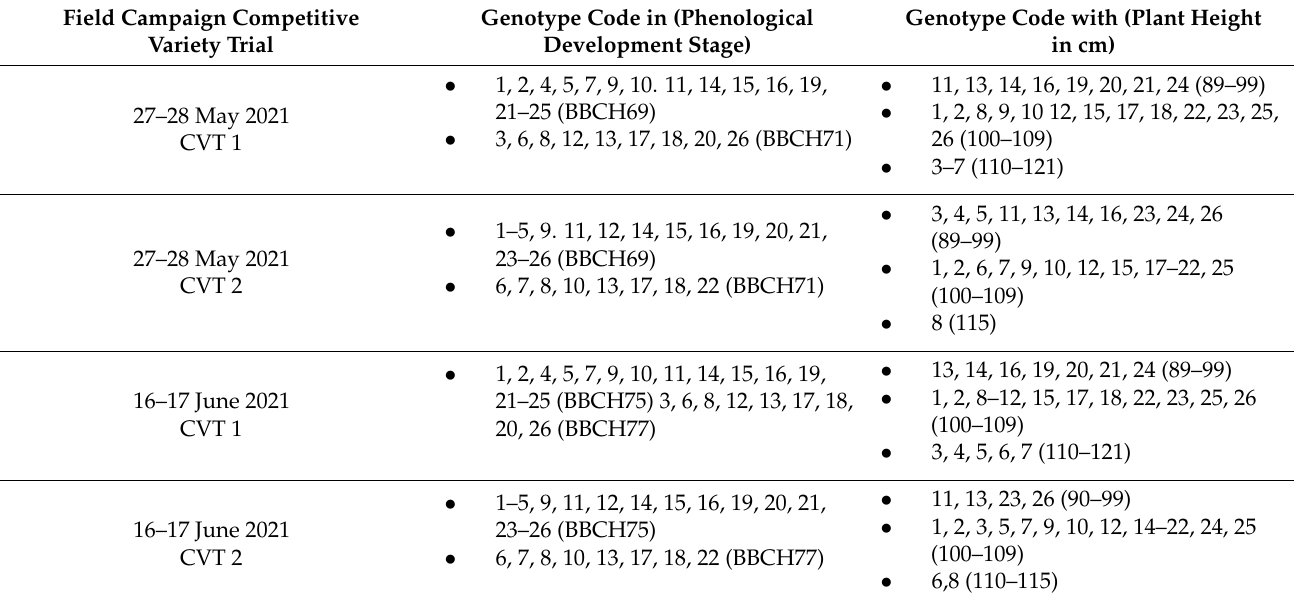
Table A2. Details of the ground-measured phenophases and plant height during the two field campaigns.